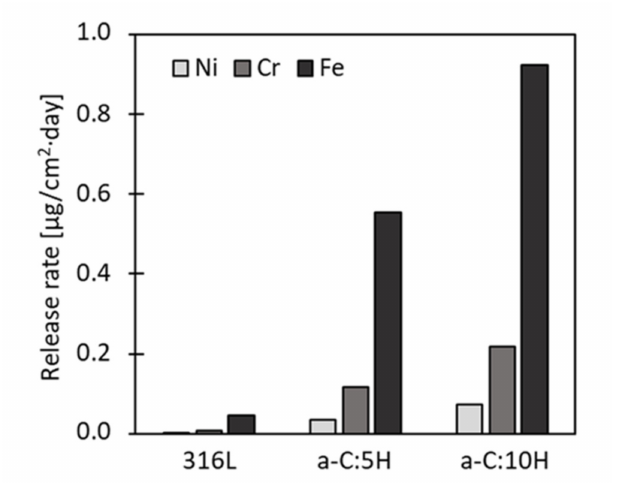
Figure 4. Metal release rates of the uncoated and coated (a-C:5H and a-C:10H) SS316L samples during 30 days of